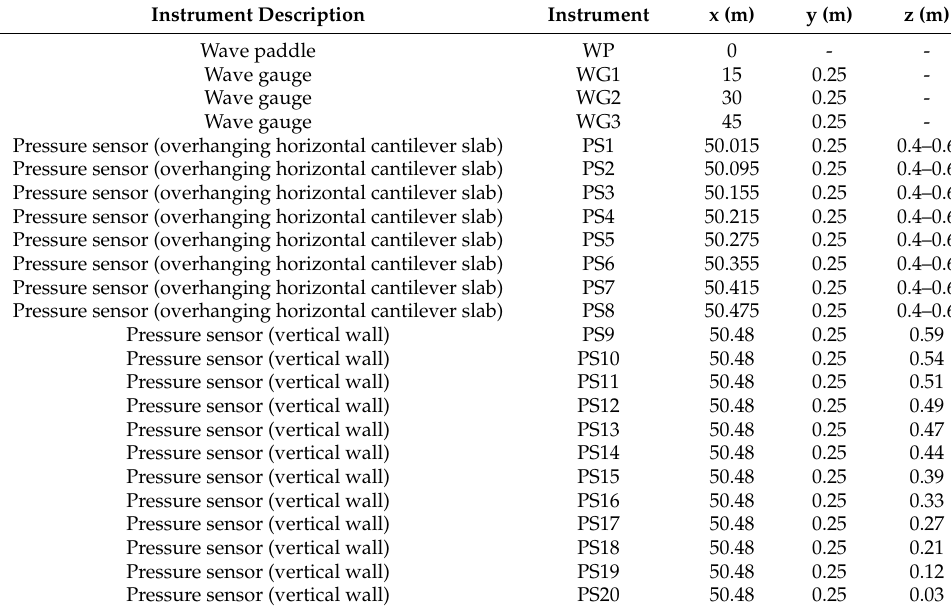
Table 2. The locations of different